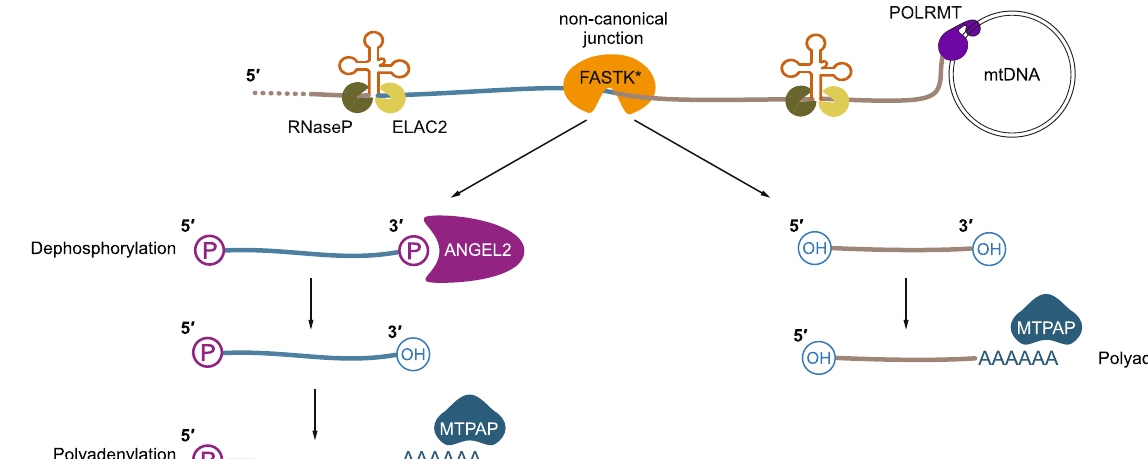
Fig. 7 | ANGEL2 phosphatase activity is required for the maturation of mRNAs that undergo non-canonical processing. Model of the non-canonical processing of mitochondrial RNA. The mitochondrial RNA polymerase, POLRMT, transcribes long,polycistronictranscripts,whicharecleavedbyRNasePandELAC2atthetRNA